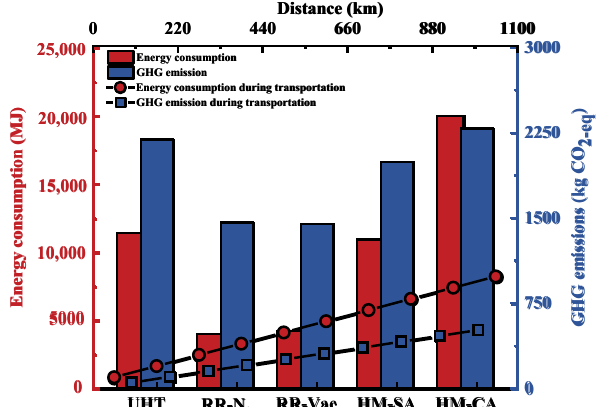
Figure 12. Effect of transportation distance (using lorry 3.5–7.5 t) in spent LIB recycling systems on the energy consumption (dark red circles) and GHG emission (dark blue squares) of the collection and transportation phase as compared to those of the rest part of the recycling methods.